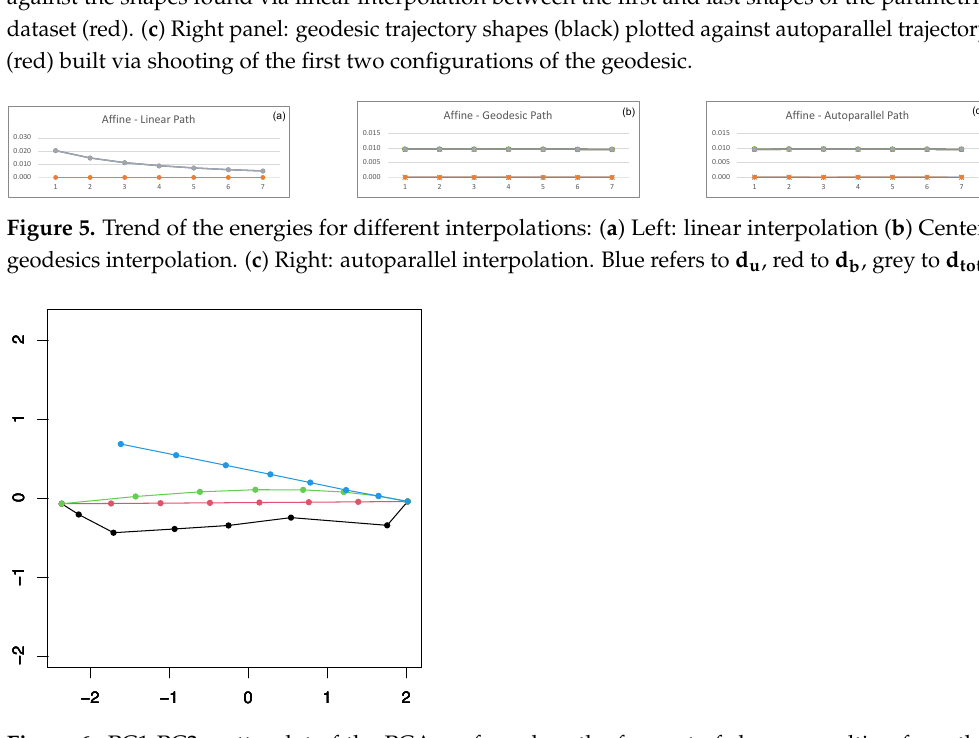
Figure 6. PC1-PC2 scatterplot of the PCA perfomed on the four set of shapes resulting from the general affine case. PC1 explains 97.2% of total variance, while PC2 explains 2.66%. Black refers to the optimized shapes, red to the linearized, green to the original shapes, and cyan to the shooted shapes. Table 2. Values of the energies for the affine general case; d u represents the affine component of the Γ -energy, d Γ -energy. b the non-affine component, and d tot the total LINEAR GEODESIC A-PARALLEL d u d b d tot d u d b d tot d u d b d tot